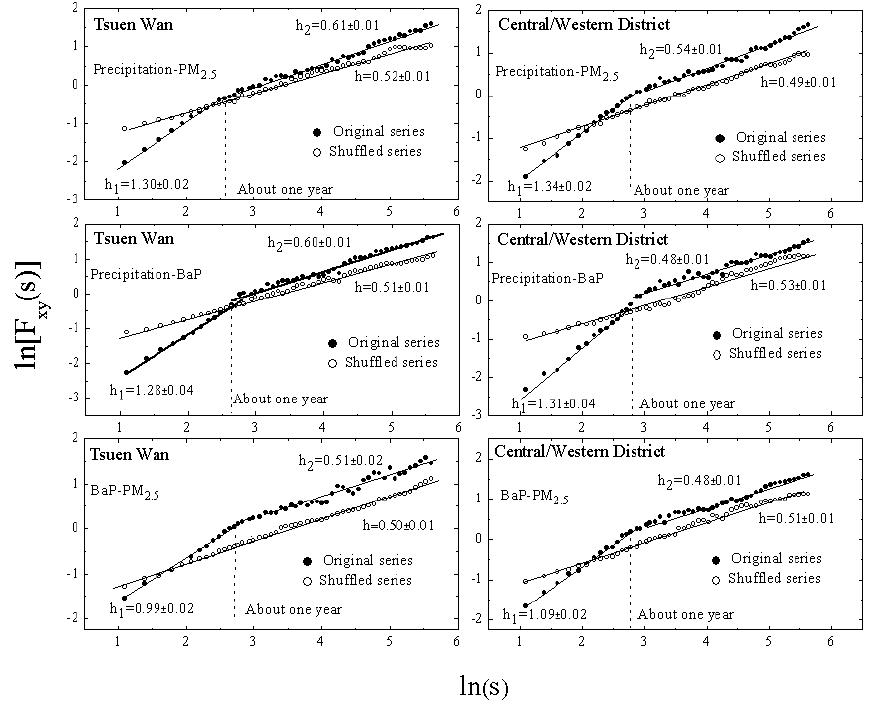
Figure 2. Detrended cross-correlation analysisplot for Tsuen Wan and the Central/Western District.